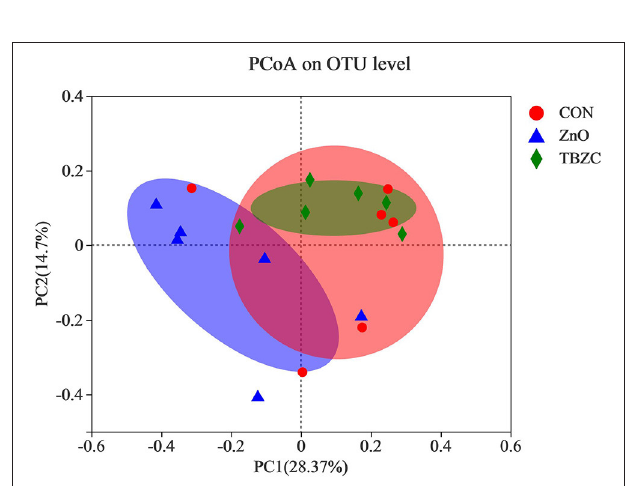
FIGURE 2 | Principal coordinate analysis (PCoA) of the community structure in the fecal samples based on unweighted UniFrac distances ( n = 6). CON, a control diet without any Zn source addition; ZnO, CON + 1,600mg Zn/kg from zinc oxide; TBZC, CON + 1,000mg Zn/kg from tetrabasic zinc